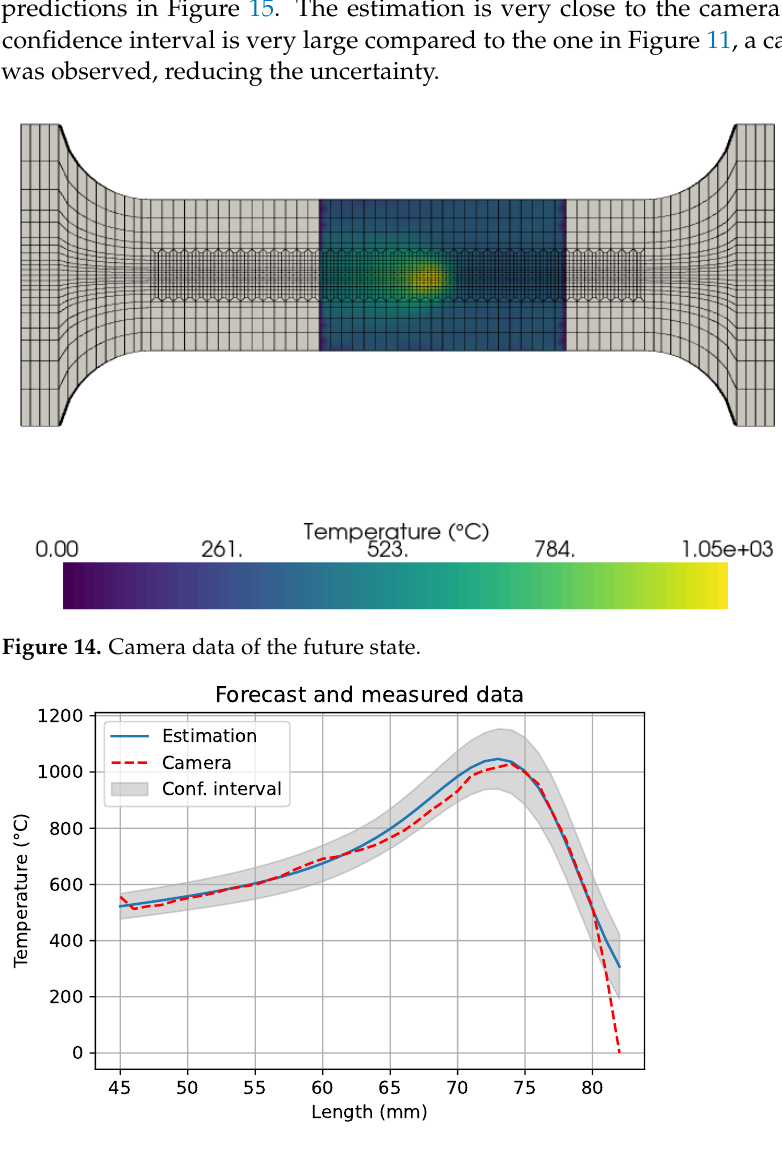
Figure 15. Forecasted temperature and camera